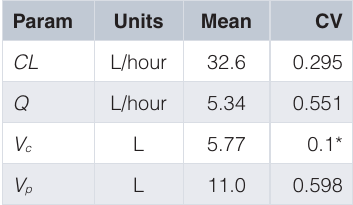
and C are drug concentrations in the central and peripheral compartments, c p